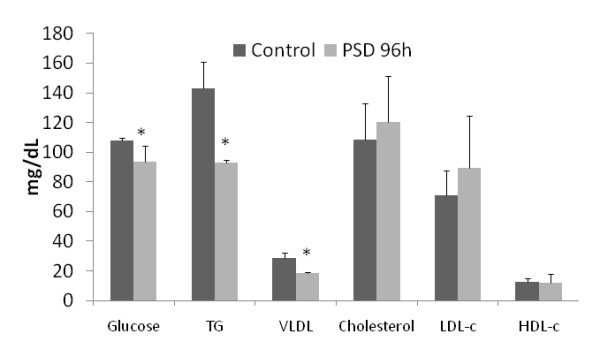
Metabolic profile.